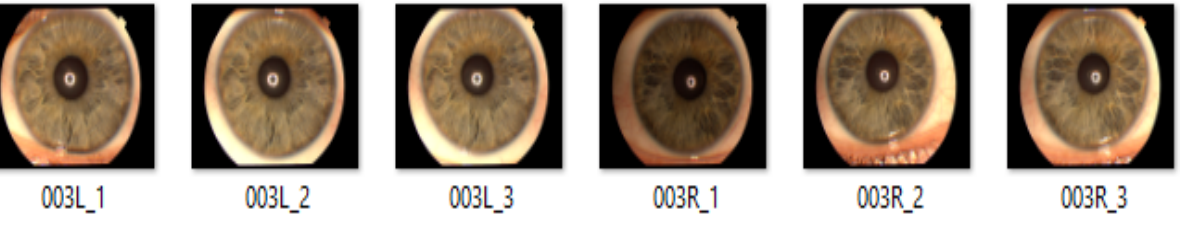
Figure 1. Sample of the